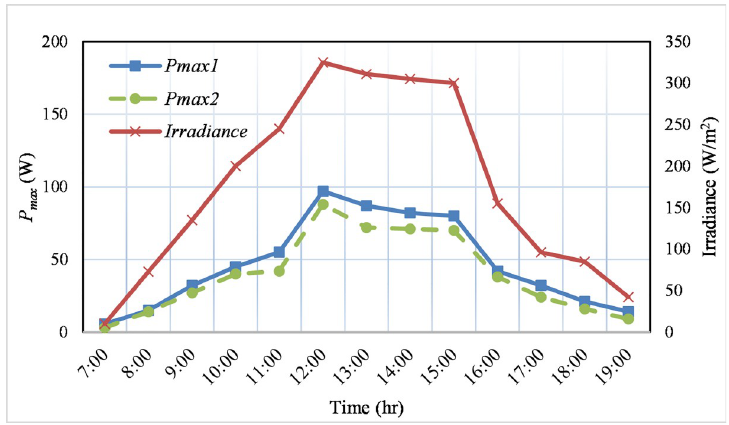
Fig 16. Maximum power of the two monocrystalline type PV panels and irradiance in a cloudy (slight rain) day.